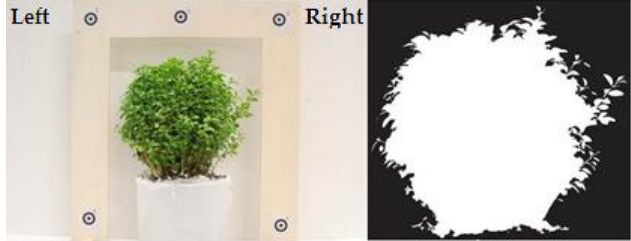
Figure 5. Bush and reference frame used for area determination ( Left ) and binary image obtained from Matlab ( Right ).